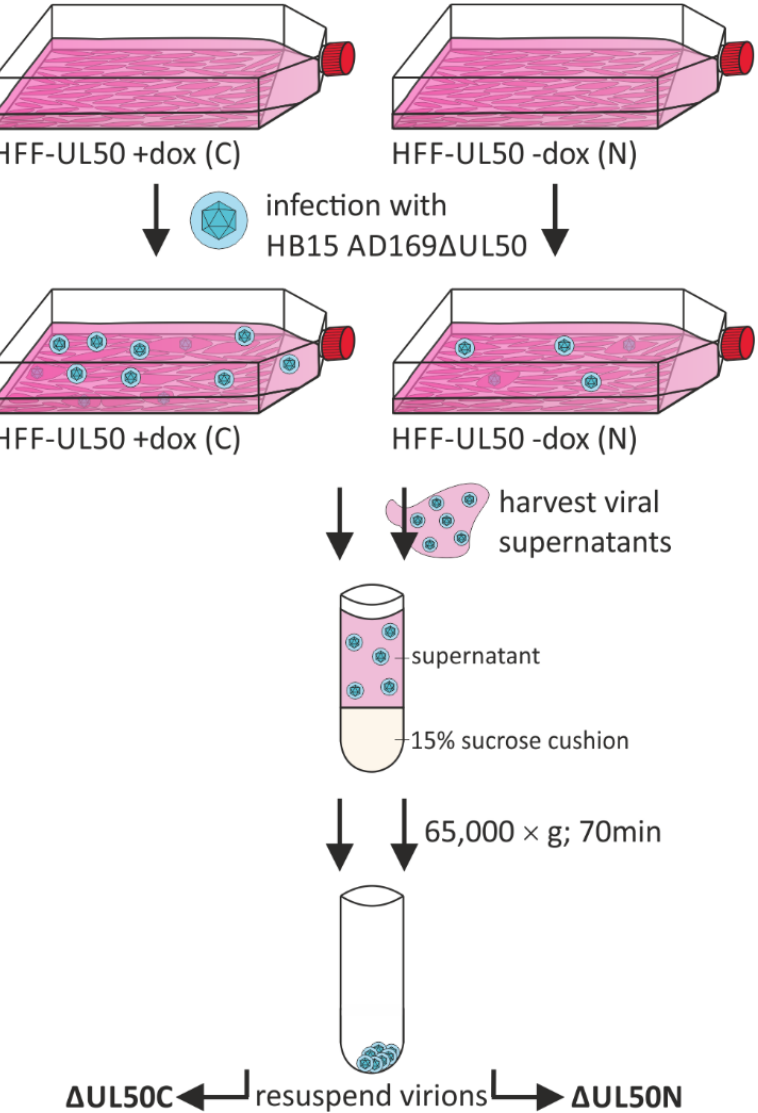
Figure 1. Schematic depiction of the purification procedure of ∆ UL50 particles. HFF-UL50 cells, either dox-induced or uninduced were infected with HCMV ∆ UL50. Viral supernatants were harvested at 4 and 8 d p.i. and used for particle purification by ultracentrifugation through a sucrose cushion. ∆ UL50C particles, derived from pUL50-complementing conditions, and ∆ UL50N, from non-complementing conditions, were resuspended in VSP buffer and stored at − 80 ◦ C. For each type of conditions, ∆ UL50C or ∆ UL50N, three comparable replicates of the particle preparations (samples 1, 2, 3; see Figure S1) were